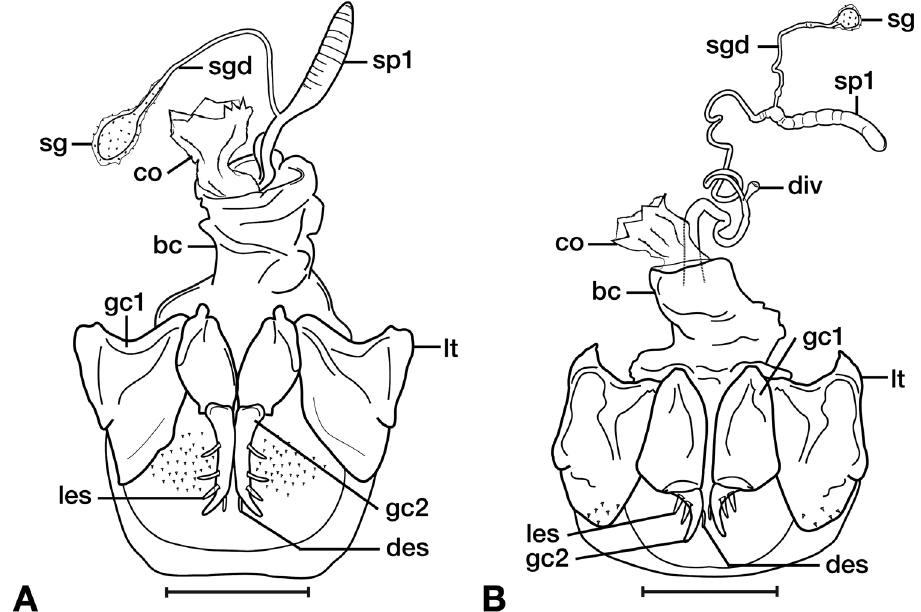
Figure 110. Line drawings of the female reproductive tract, ventral aspect, of A Pericalus formosanus Dupuis B Serrimargo schenklingi (Dupuis). Legend: bc bursa copulatrix; co common oviduct; des dorsal ensiform setae; div diverticulum; gc1 gonocoxite 1; gc2 gonocoxite 2; les lateral ensiform setae; lt lateral tergite; sg spermathecal gland; sgd spermathecal gland duct; sp1 spermatheca 1. Scale bars: 0.5